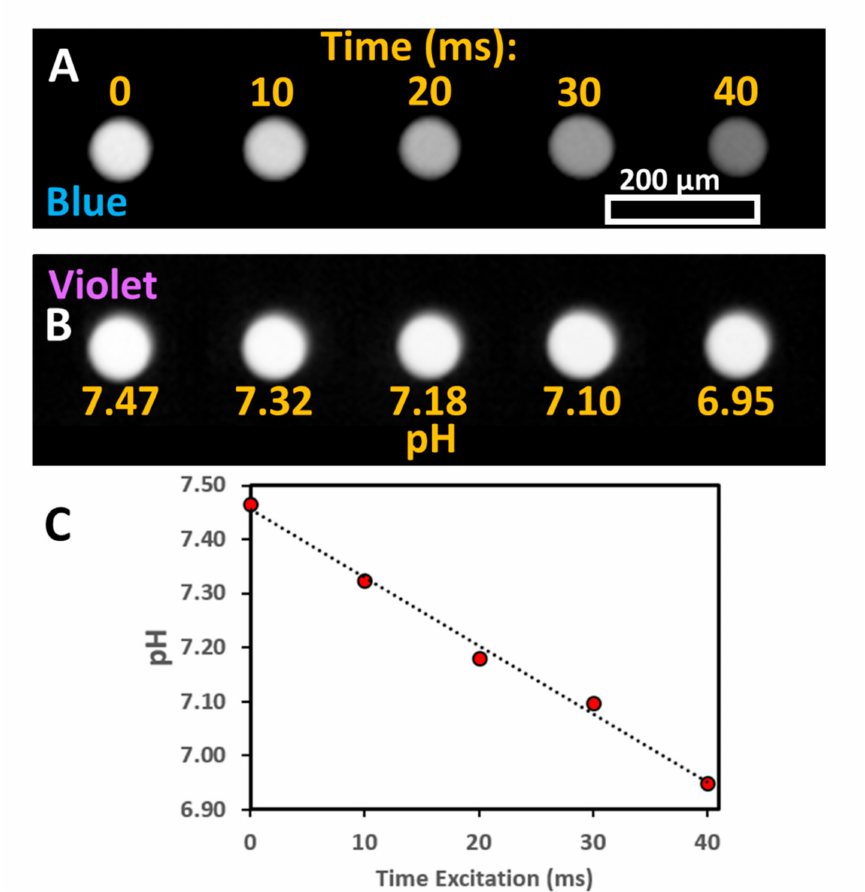
Figure 1. Linear array of droplets with increasing irradiation times from left to right. ( A ) Fluorescence from blue excitation (436 nm). ( B ) Fluorescence from violet excitation (395 nm). pH of droplets as determined from blue to violet fluorescence intensity ratio based on calibration curve as shown in Supplemental Figure S2. ( C ) Droplet pH with increasing irradiation time with fit to a linear